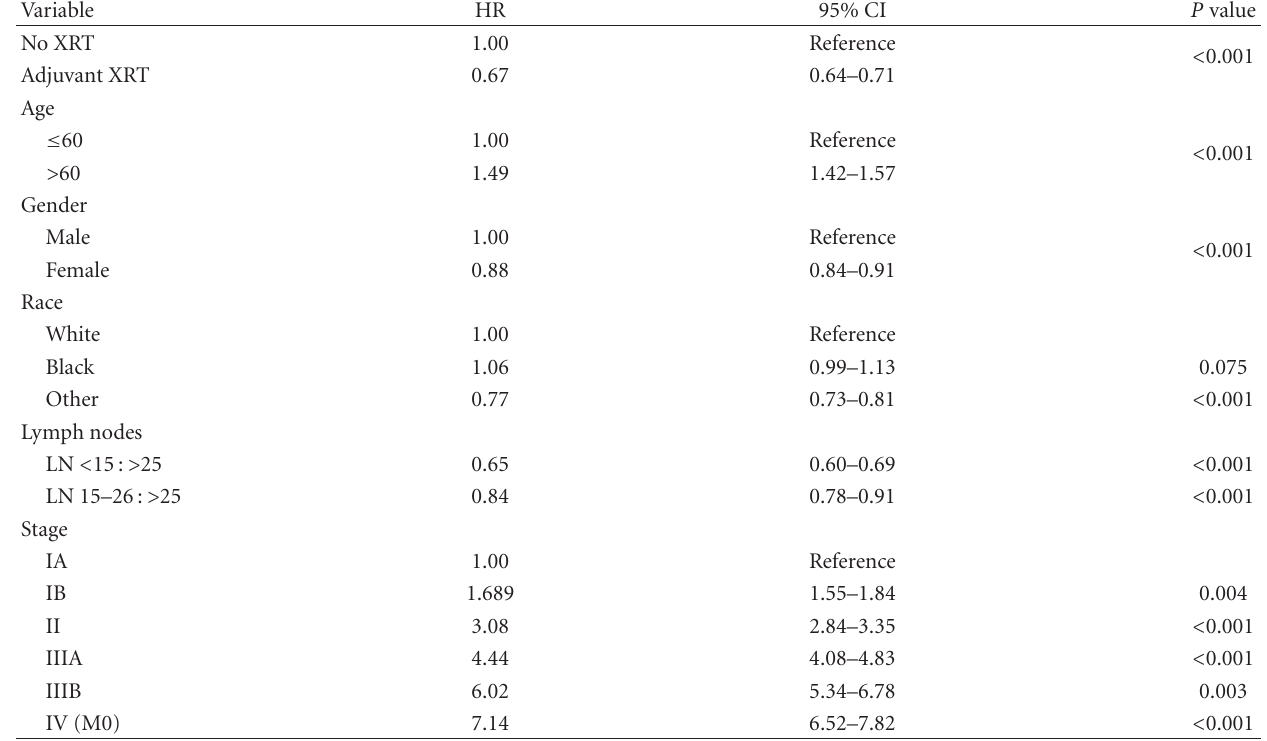
Table 3: Cox multivariate regression analysis for overall survival.